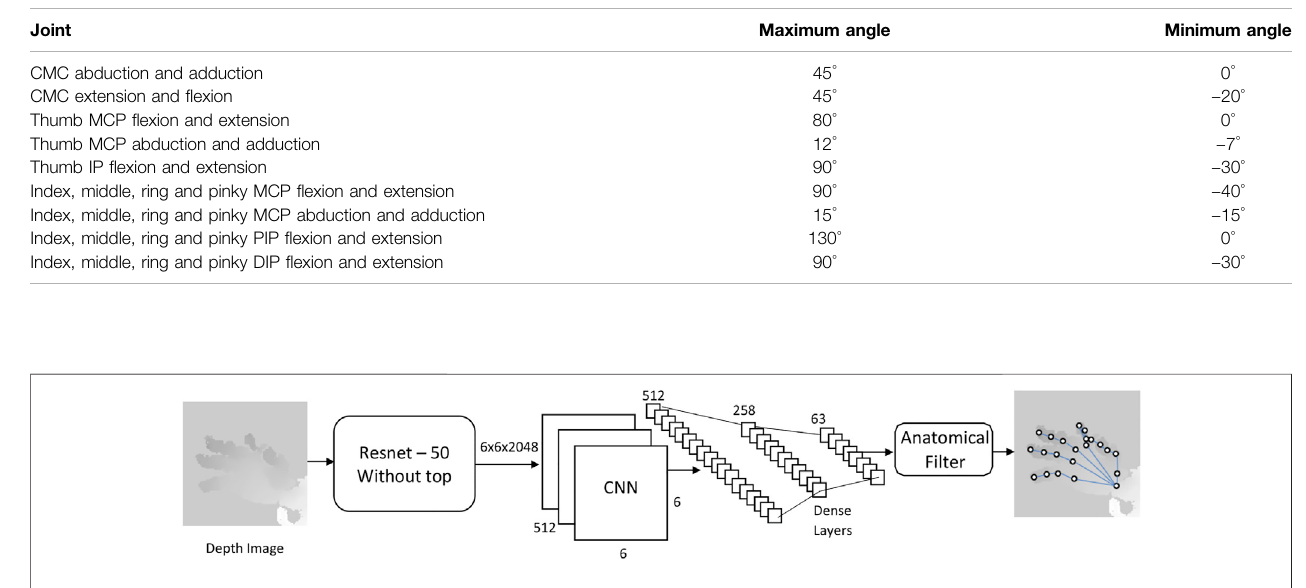
FIGURE 3 | Architecture of the model used for the hand tracker with the anatomical fi lter.